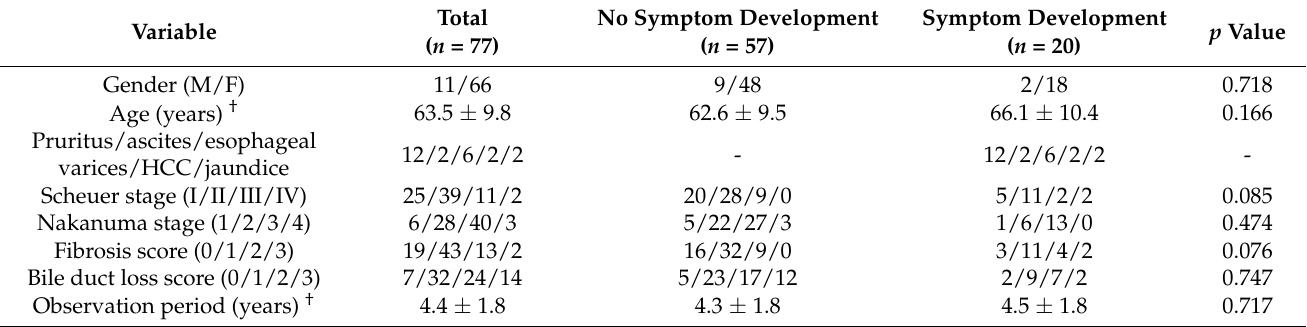
Table 1. Clinical characteristics of patients with primary biliary